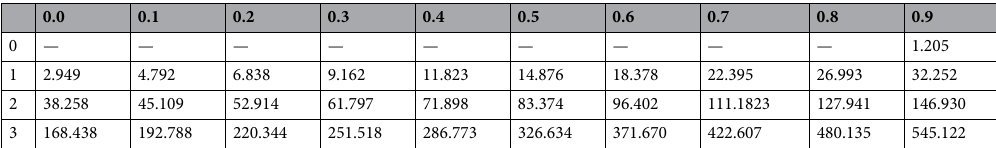
Table 3. Coefficients for the different values of the ratio entropy to energy law obtained by solving Eq. 31: λ T = coefficient ( × 10 6 nm K). Integers are in the left column and decimals in the upper row. For example, the coefficient for ratio equal to 2.4 is 71.898 × 10 6 nm